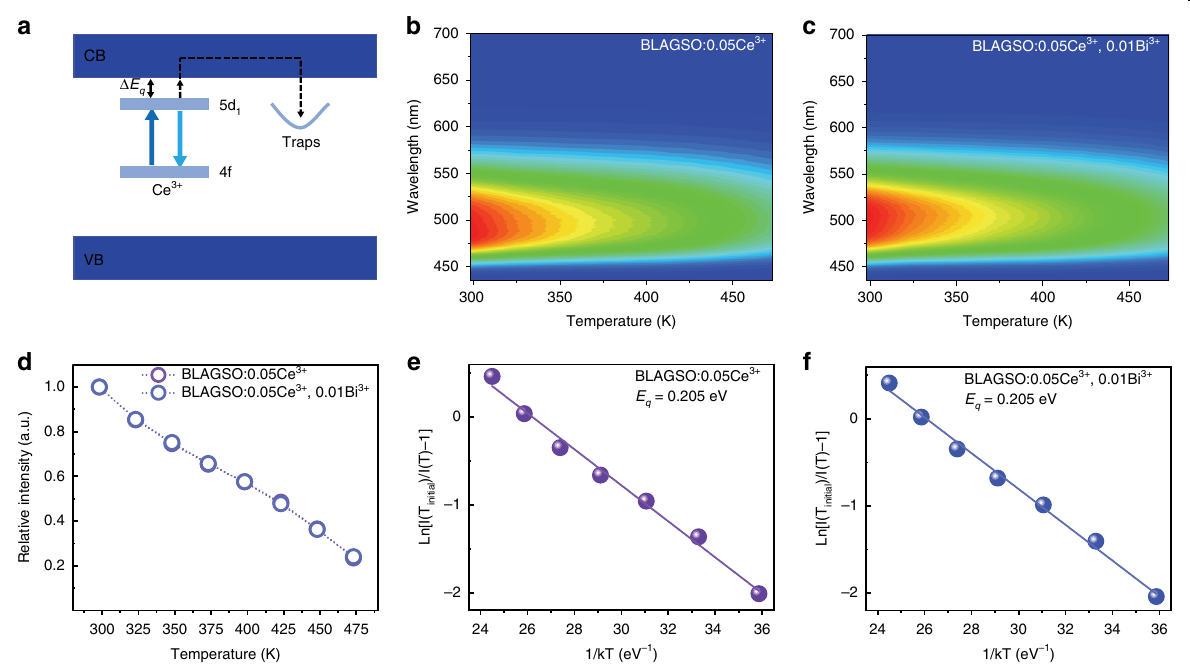
Fig. 4 Temperature-dependent photoluminescence properties. a Thermal ionization process in BLAGSO:Ce 3 + and BLAGSO:Ce 3 + , Bi 3 + . b , c The corresponding temperature-dependent PL spectra of BLAGSO:0.05Ce 3 + and BLAGSO:0.05Ce 3 + , 0.01Bi 3 + . d Temperature-dependent PL intensity ratios I ( T )/ I ( T initial ) of BLAGSO:0.05Ce 3 + and BLAGSO:0.05Ce 3 + , 0.01Bi 3 + . e , f The relation between Ln[ I ( T initial )/ I ( T ) – 1] and 1/ kT for BLAGSO:0.05Ce 3 + and BLAGSO:0.05Ce 3 + , 0.01Bi 3